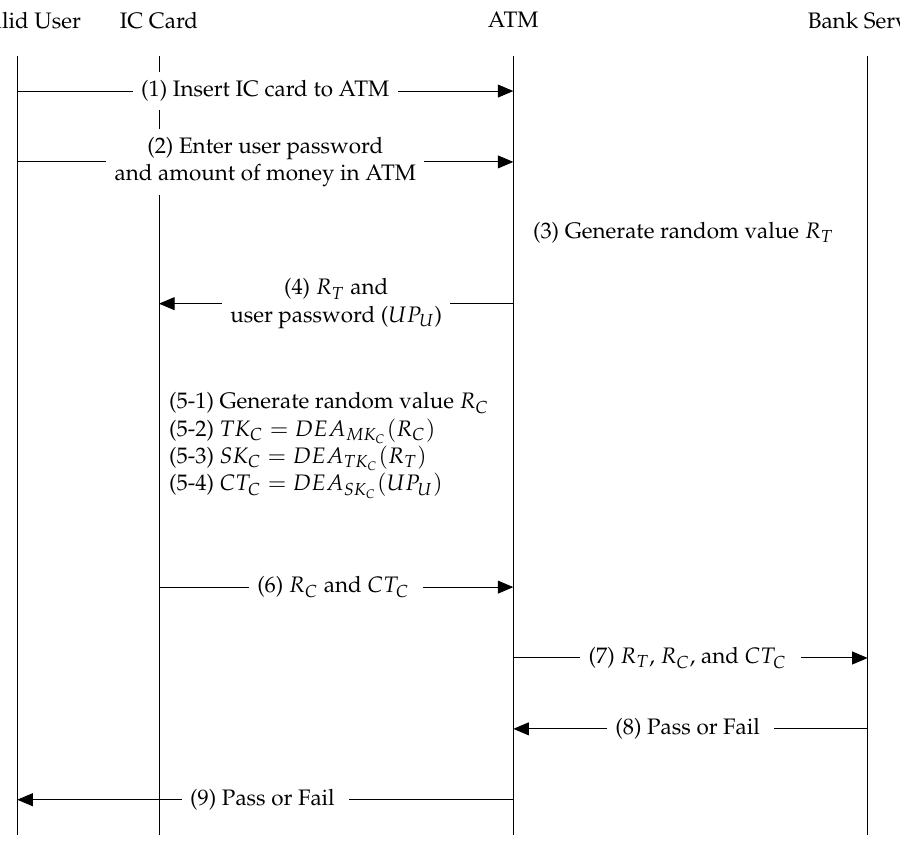
Figure 1. Financial IC (Integrated circuit) card protocol. ATM: automated teller